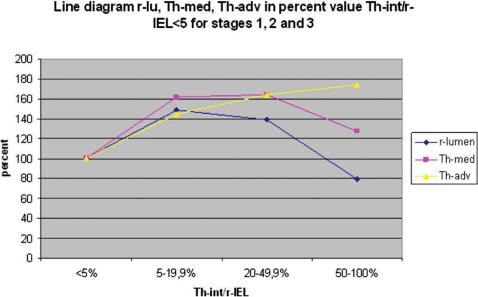
Line diagram radius lumen (r-lu), thickness media (Th-med) and thickness adventitia (Th-adv) in percent of reference values Th-int/r-IEL<5 (100%) for stages Th-int/r-IEL (thickness intima/radius Internal Elastic Lamina).